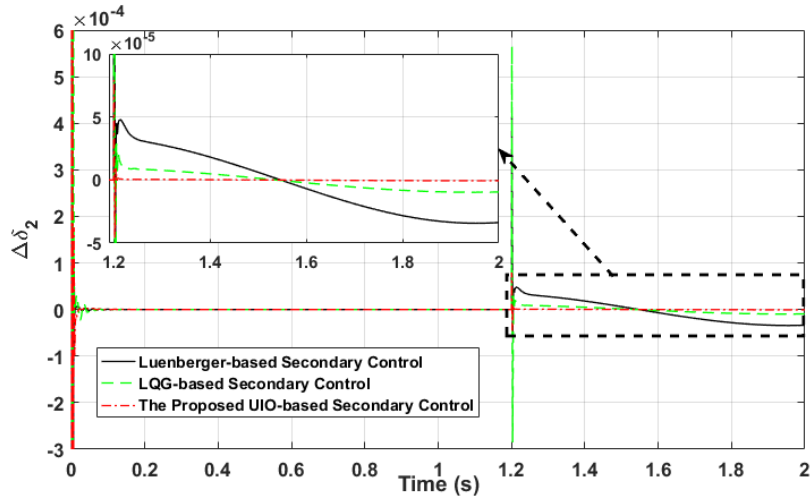
Figure 10. Second inverter angle δ 2 in scenario 2 (False Data Injection (FDI) into second inverter’s actuator).